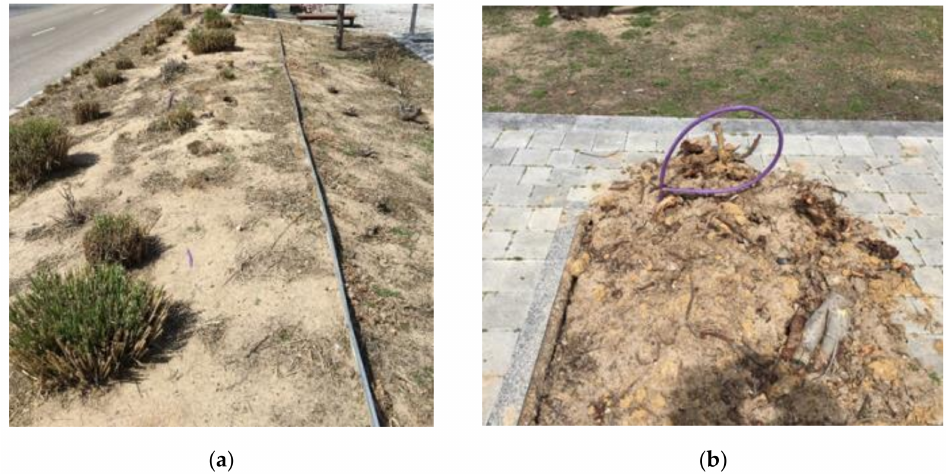
Figure 10. Severe effect of irrigation mismanagement: ( a ) under irrigation in FLO, ( b ) over irrigation in